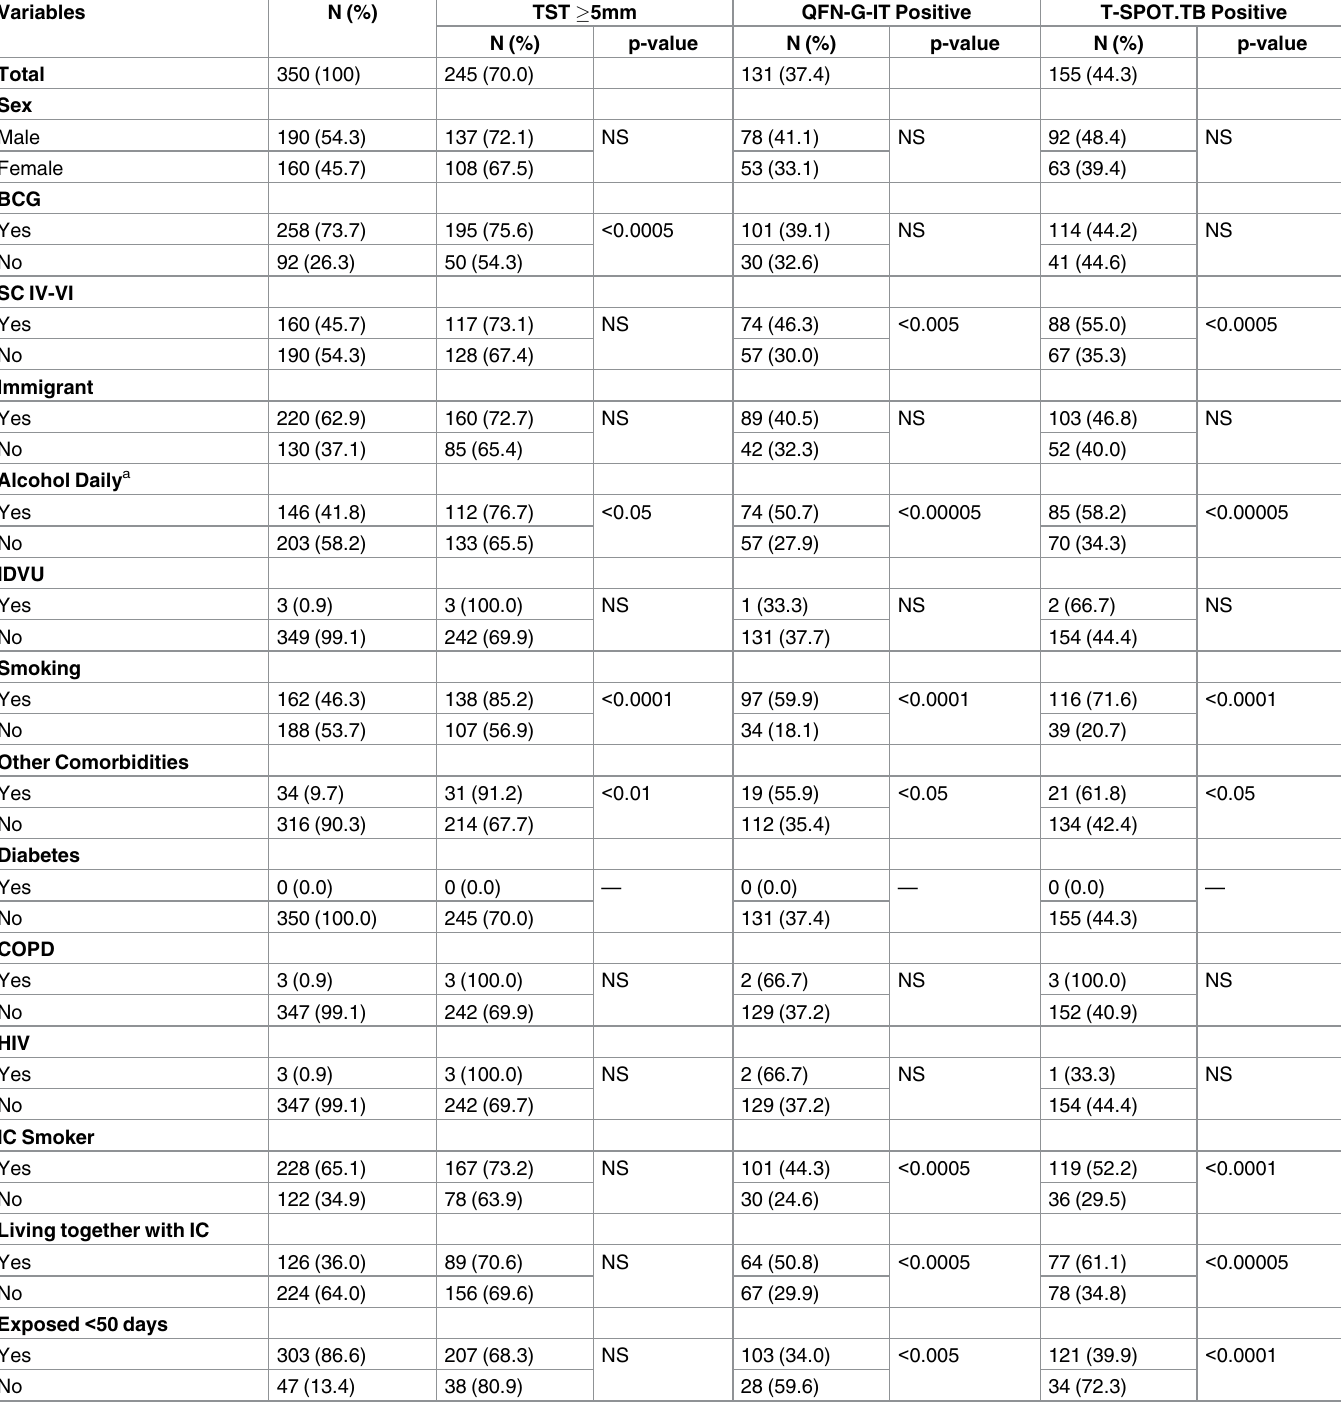
Table 2. Main demographic characteristics and risk factors associatedwith TST and IGRAs positivity in individuals coming from contact tracing studies (including secondary TB